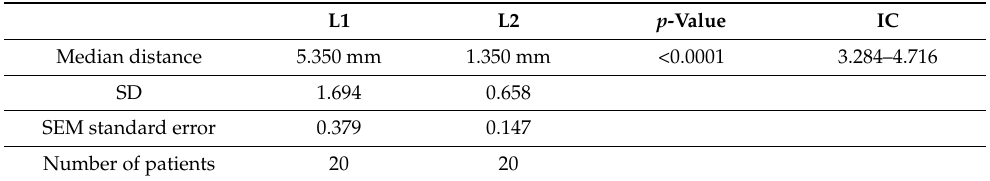
Table 4. Analysis of accuracy of measurement over 20 patients by paired t